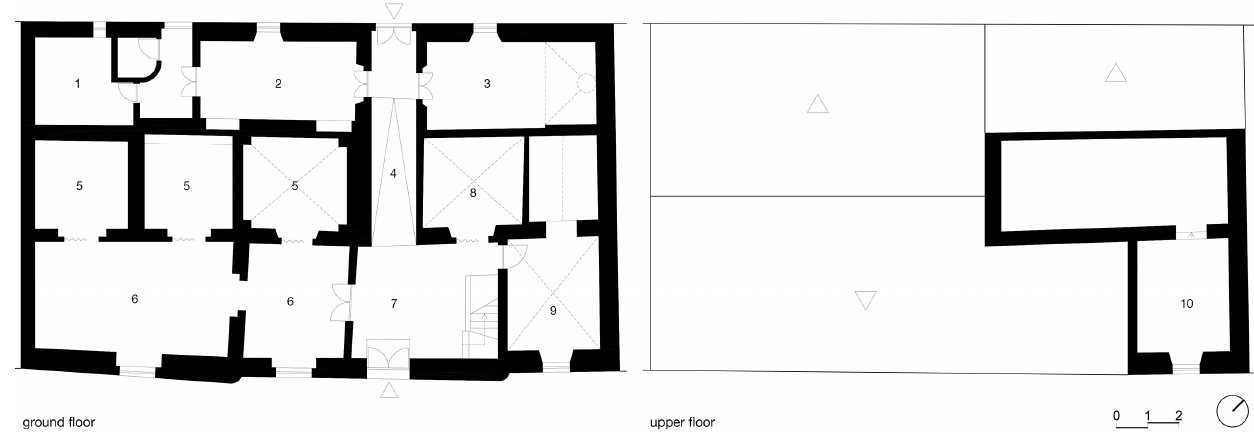
Figure 7. Floor plans (1—bathroom; 2—kitchen; 3—old kitchen (living room); 4—corridor; 5—alcove; 6—living room; 7—entrance; 8—library; 9—bedroom;